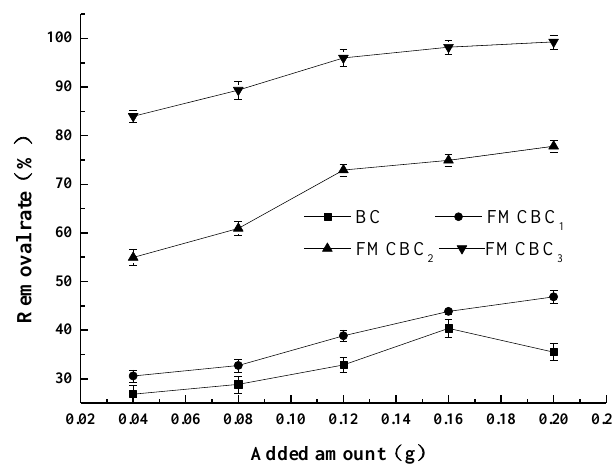
Figure 5. Removal rate of FMCBC 1 , FMCBC 2 and FMCBC 3.